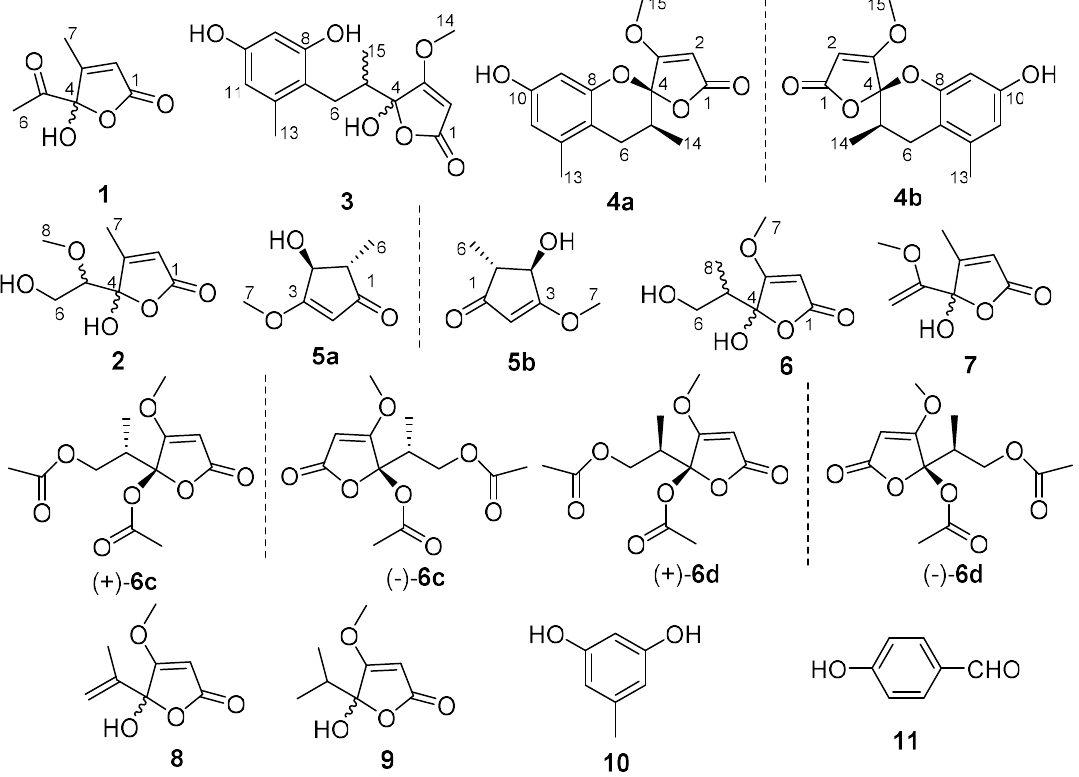
Figure 1. Structures of Compounds 1 − 3 , 4a , 4b , 5a , 5b , 6 − 11 , (+)/(−)- 6c and (+)/(−)- 6d .